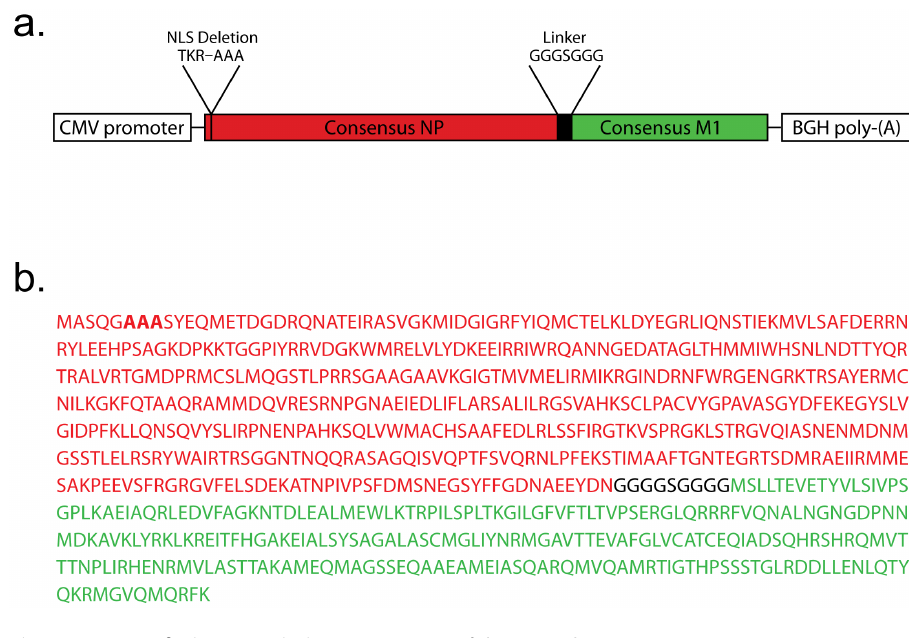
Figure 1. NPM1 fusion protein insert. a) Design of the insert showing CMV promoter, NPM1 transgene, and BGH-polyadenylation cassettes. b) Complete amino acid sequence of the consensus NPM1 fusion protein. NP is indicated in red, linker sequence is shown in black, and M1 is green. The deletion of the nuclear localization signal by mutation of TKR to AAA in NP is indicated in bold text.